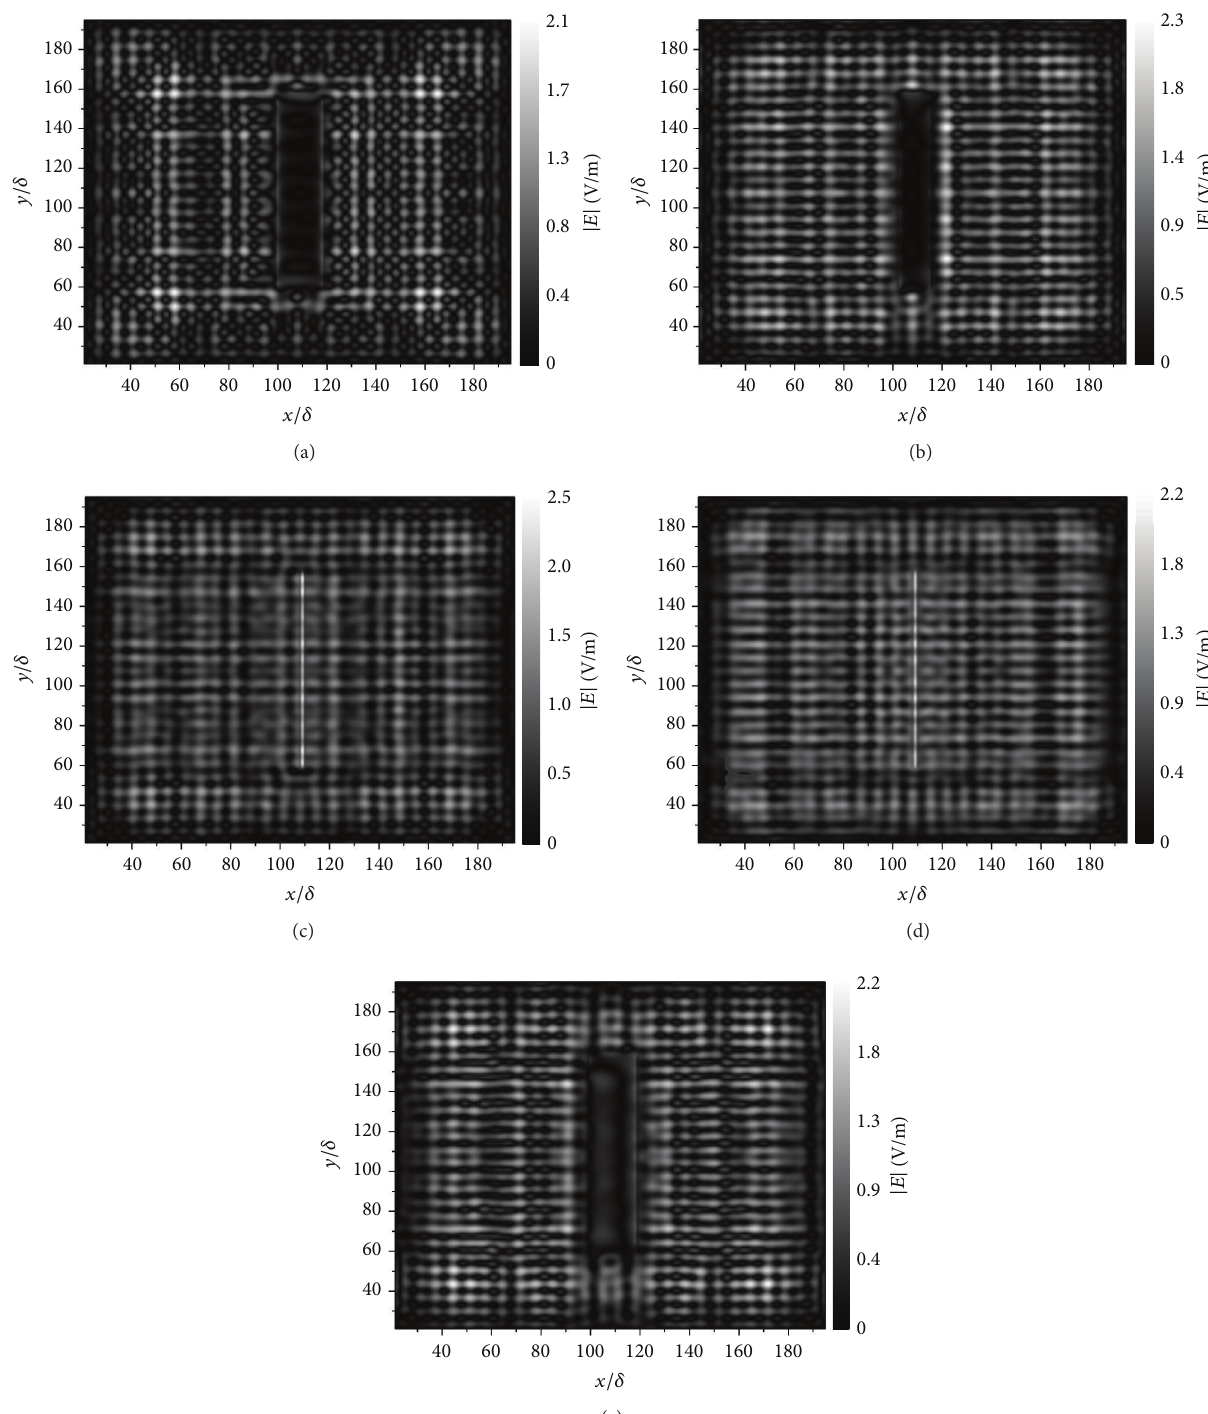
Figure 8: Electric field amplitude distributions in the 𝑧 plane of |𝐸| max of cracks with different Rck at the length 𝑙 = 100𝛿 and width 𝑤 = 20𝛿 : (a) Rck = 1 , Plane z 200; (b) Rck = 2 , Plane z 187; (c) Rck = 3 , Plane z 141; (d) Rck = 4 , Plane z 121; (e) Rck = 5 , Plane z